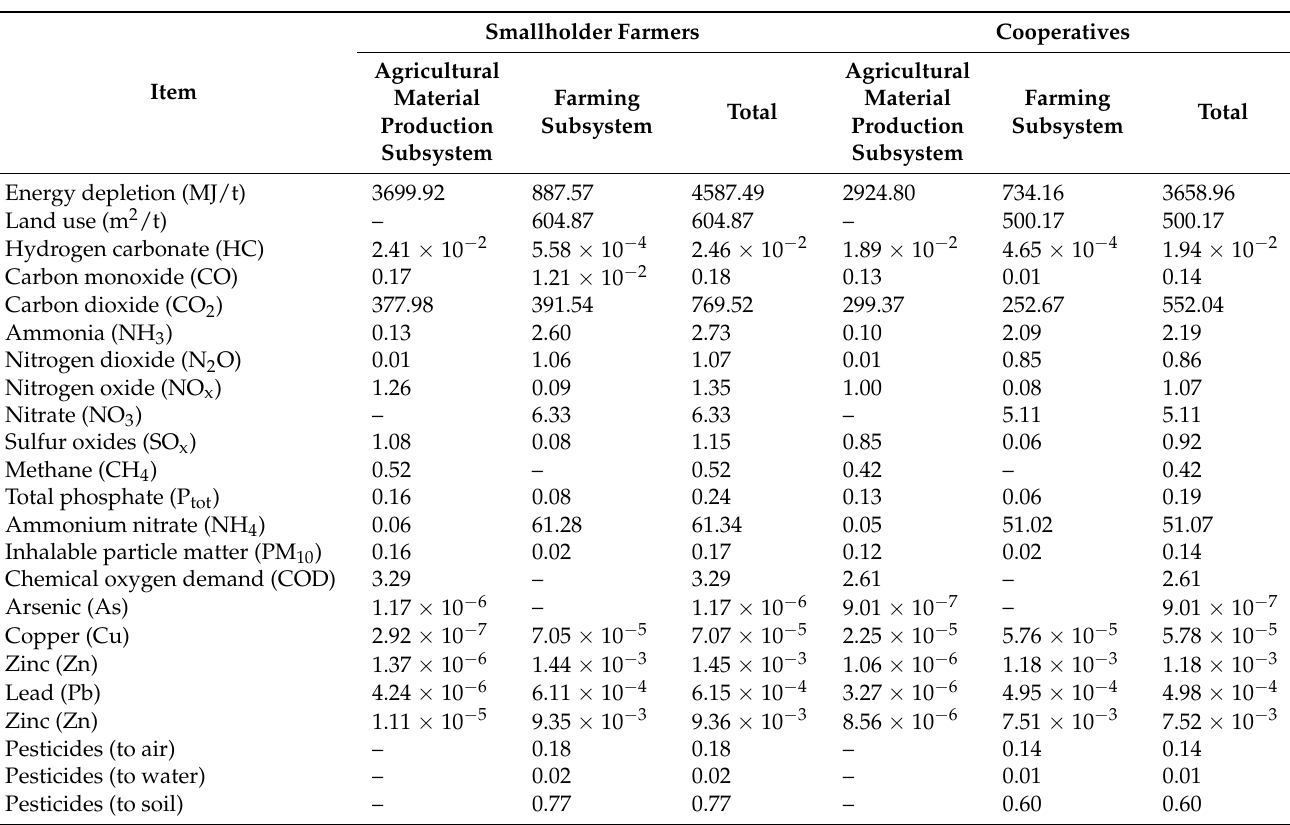
Table 3. Life cycle inventory of producing 1 ton of apples by different growers in Qingcheng County. (Unit: